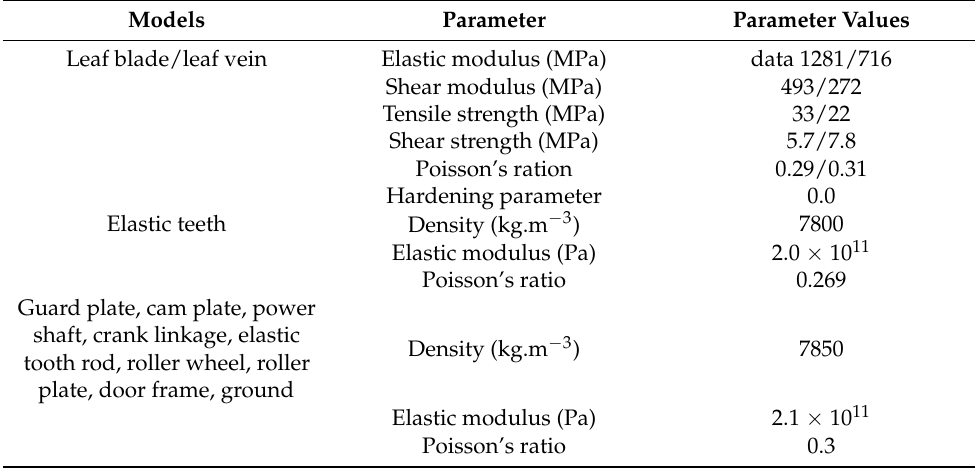
Table 2. Mechanical and material parameters of models.